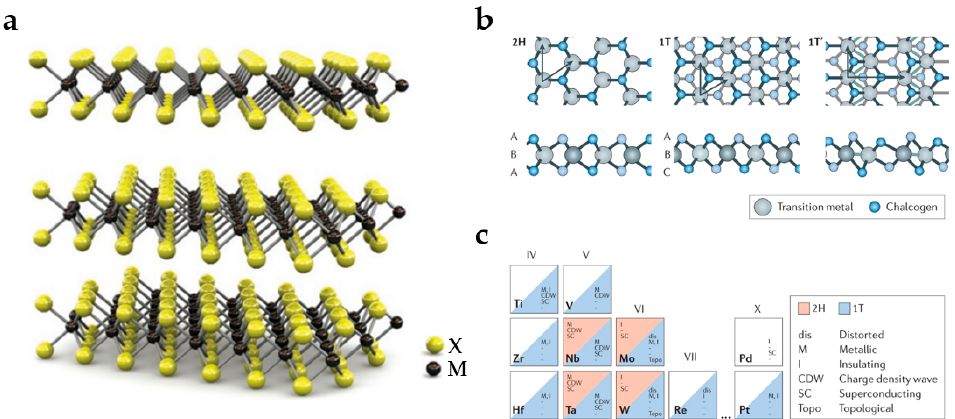
Figure 9. ( a ) The structure of TMDs. (Reprinted with permission from ref. [112] . Copyright 2011 Springer Nature Publications). ( b ) Atomic structures of monolayer TMDs in their triangular prismatic (2H), twisted octahedral (1T), and dimeric (1T ′ ) phases. (Reprinted with permission from ref. [120] . Copyright 2017 Springer Nature Publications). ( c ) The existing structural phase of the TMDs (2H, 1T, or other), as well as the twisted structural phase and the observed electronic phase. (Reprinted with permission from ref. [120]. Copyright 2017 Springer Nature Publications).